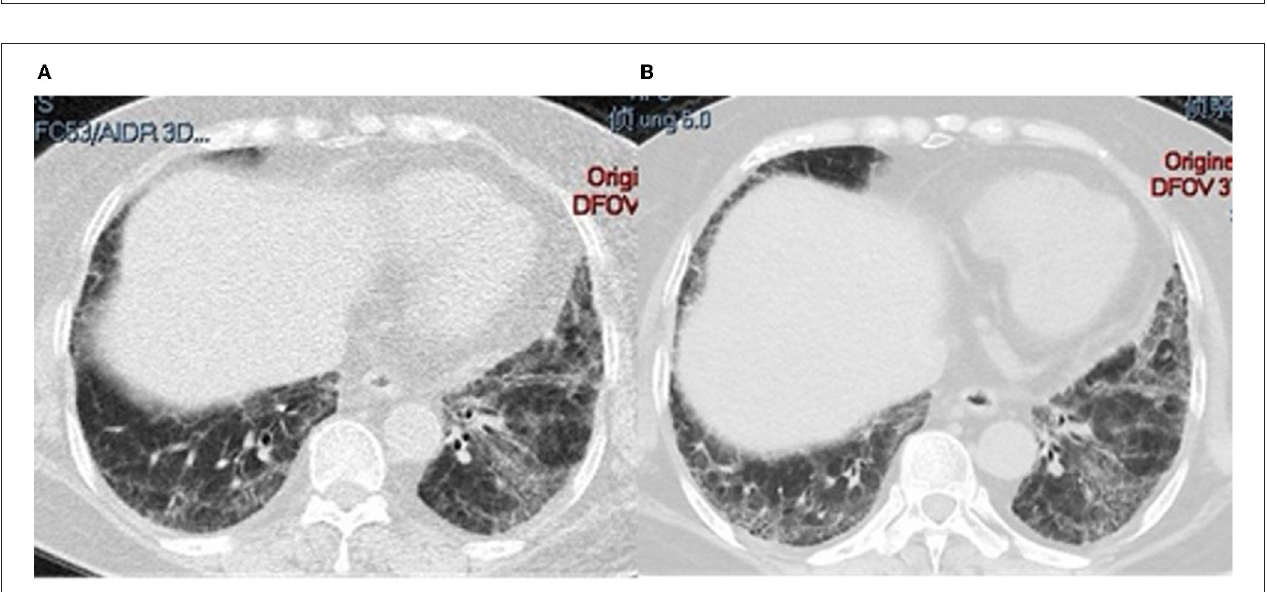
FIGURE 4 | Fellow up of patients with ILD. GCs, glucocorticoids; OS, overlapping syndrome; ISA, immunosuppressive agents.